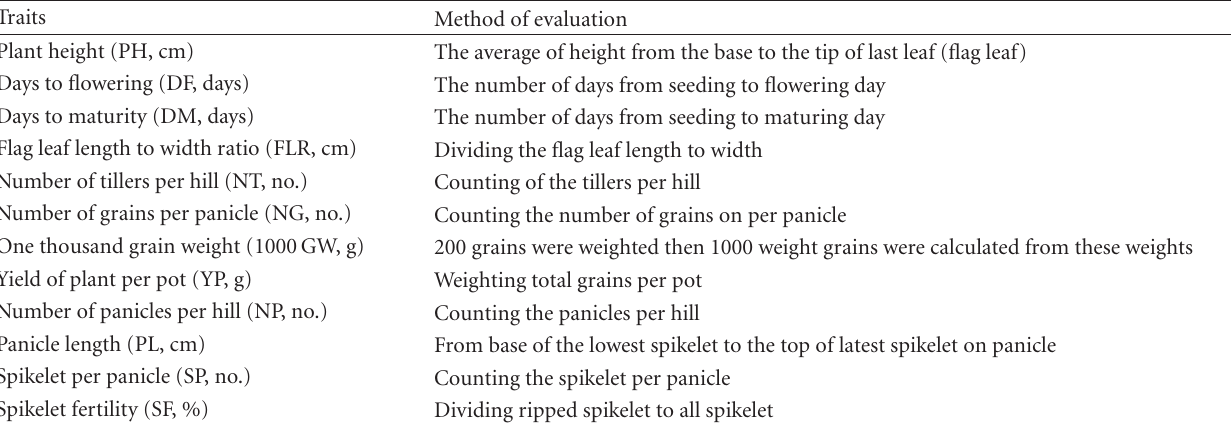
Table 2: List of quantitative traits of upland rice.